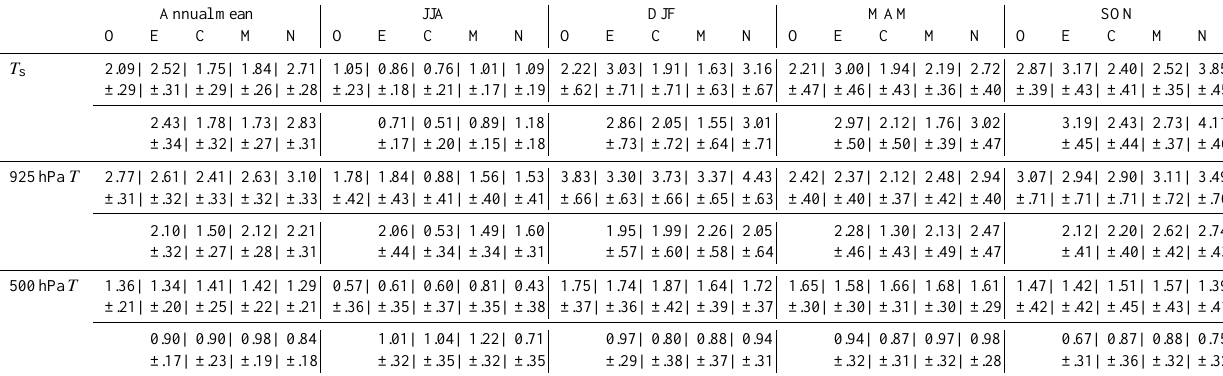
Table 3. 70–90 ◦ N average temperature trend from 1979 to 2011 in units of temperature change (in K) over the 33yr. In the case of CFSR, the trend is from 1979 to 2009 in units of temperature change over the 31yr. There are five values separated by “|”, and these five values represent Observation|ERA|CFSR|MERRA|NCEP II. Observation here refers to either GISTEMP or IGRA data. In the rows with observation (i.e., five values separated by a blank), the 70–90 ◦ N average is made with the reanalysis data corresponding to the available observation, whereas in the rows without observation (i.e., four values separated by a blank), true 70–90 ◦ N average values are used. The standard error of each trend is shown with ± in each row.